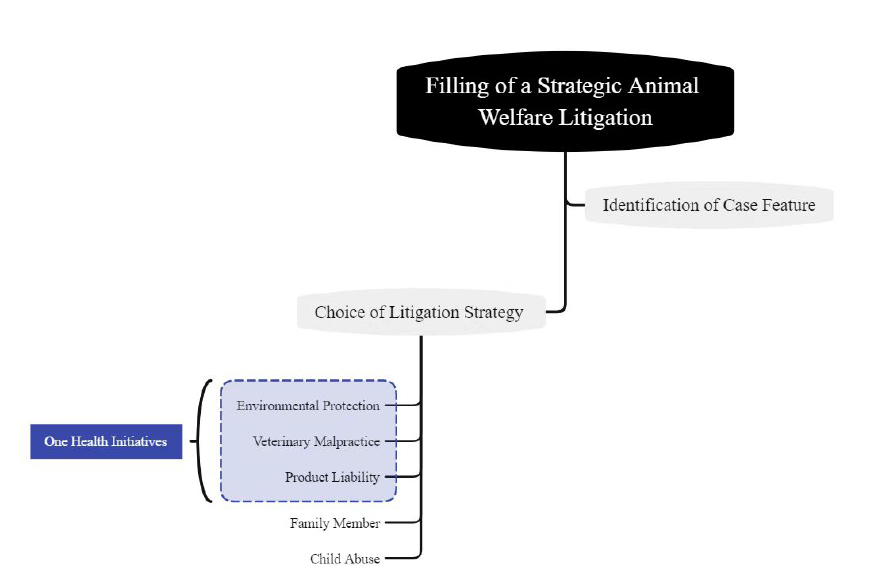
Figure 2. The way to identify a One Health litigation